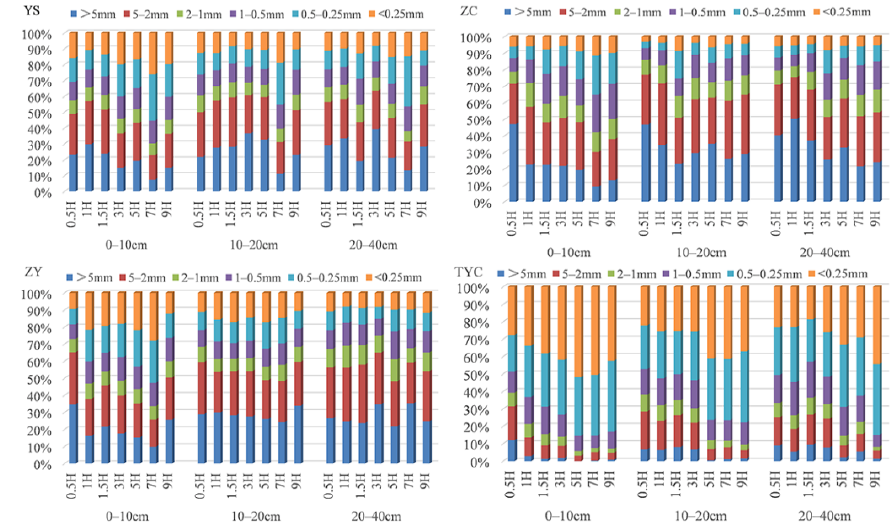
Figure 5. Soil dry stable aggregates distribution.